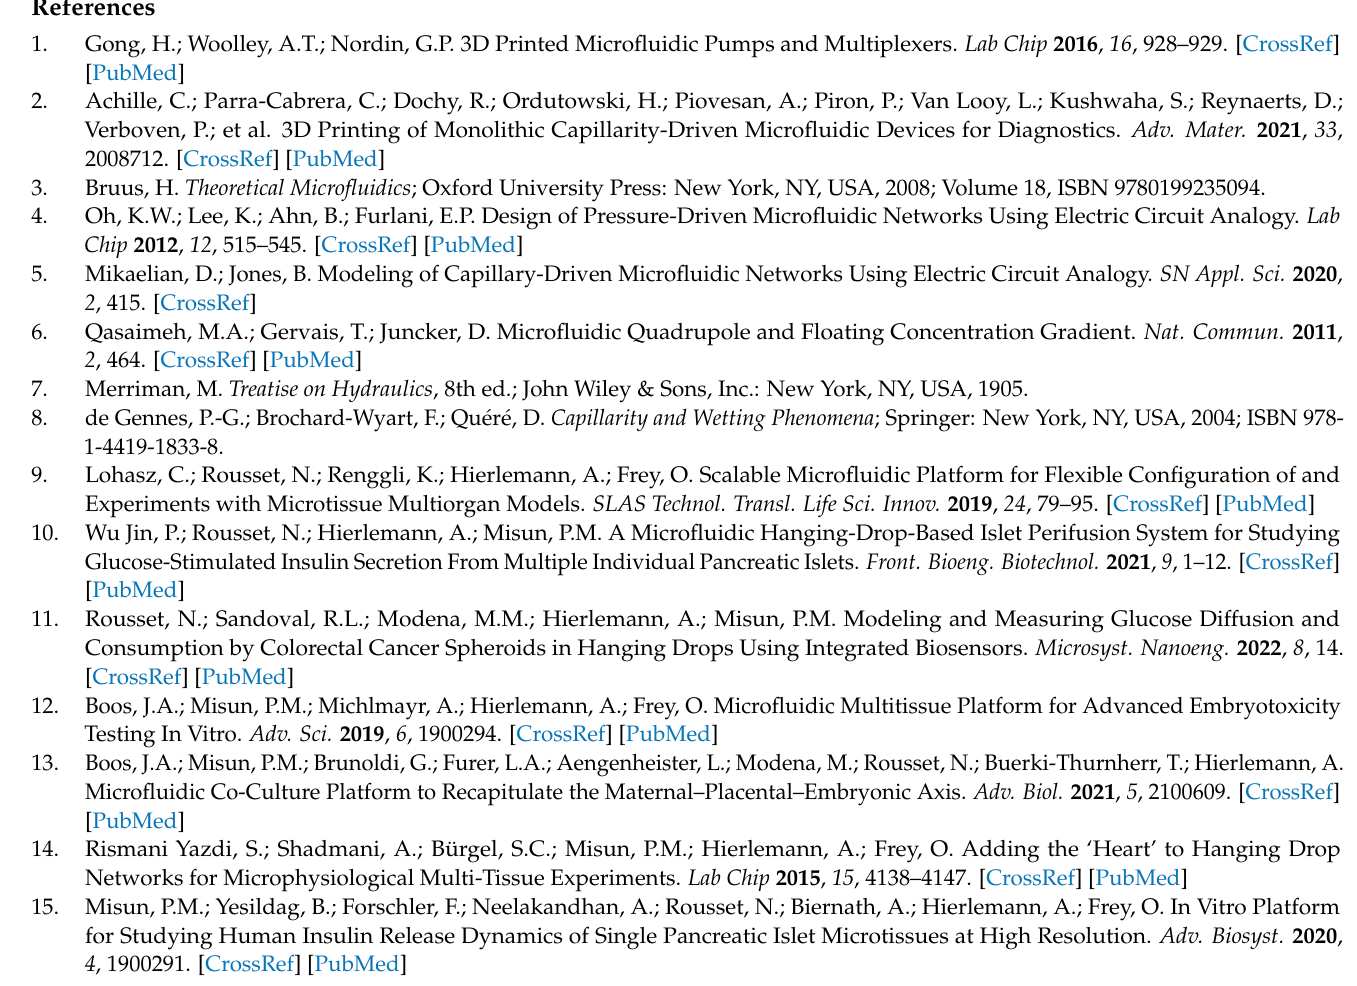
(receding capillary front), Table S3: Volume-calculating equations for all filling/emptying steps; Supplementary section on “Hanging-drop crash” with Equations